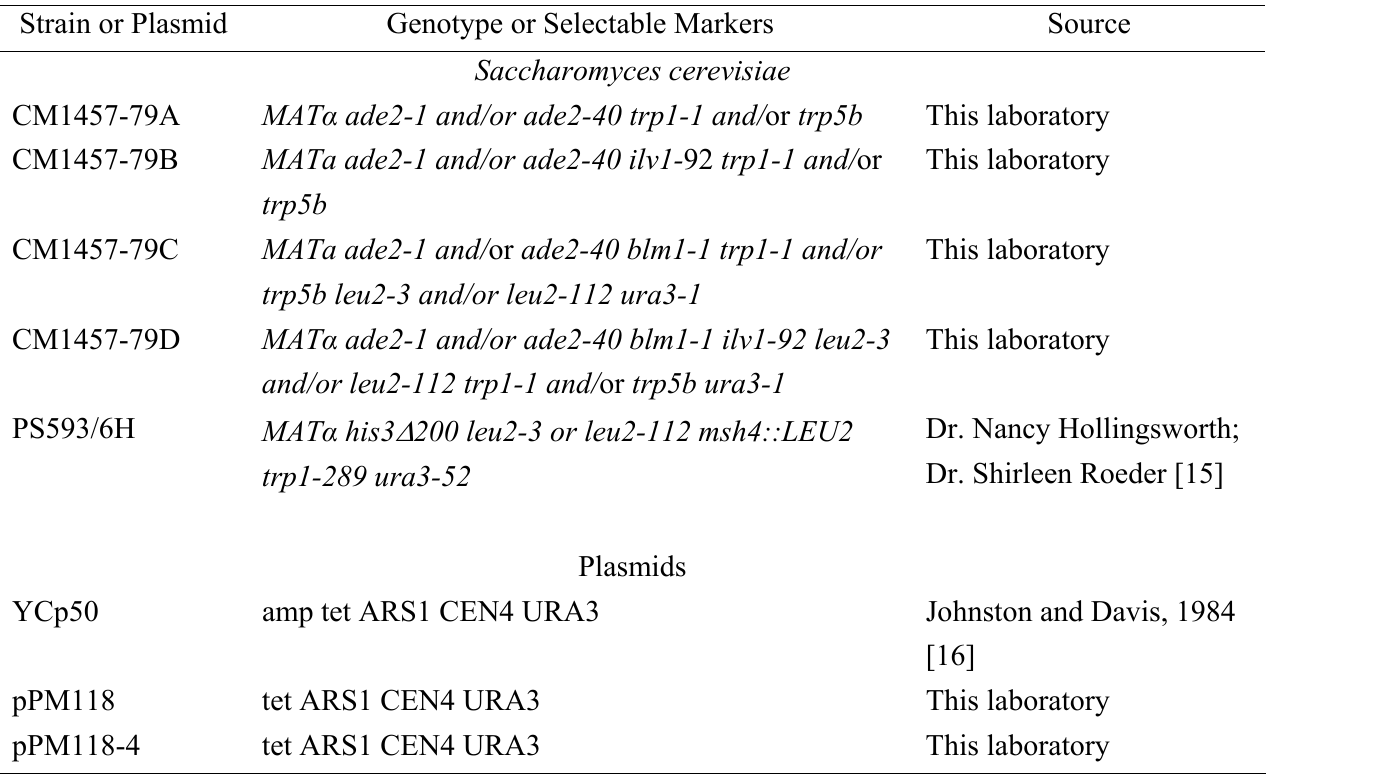
Table 1. Strains and plasmids